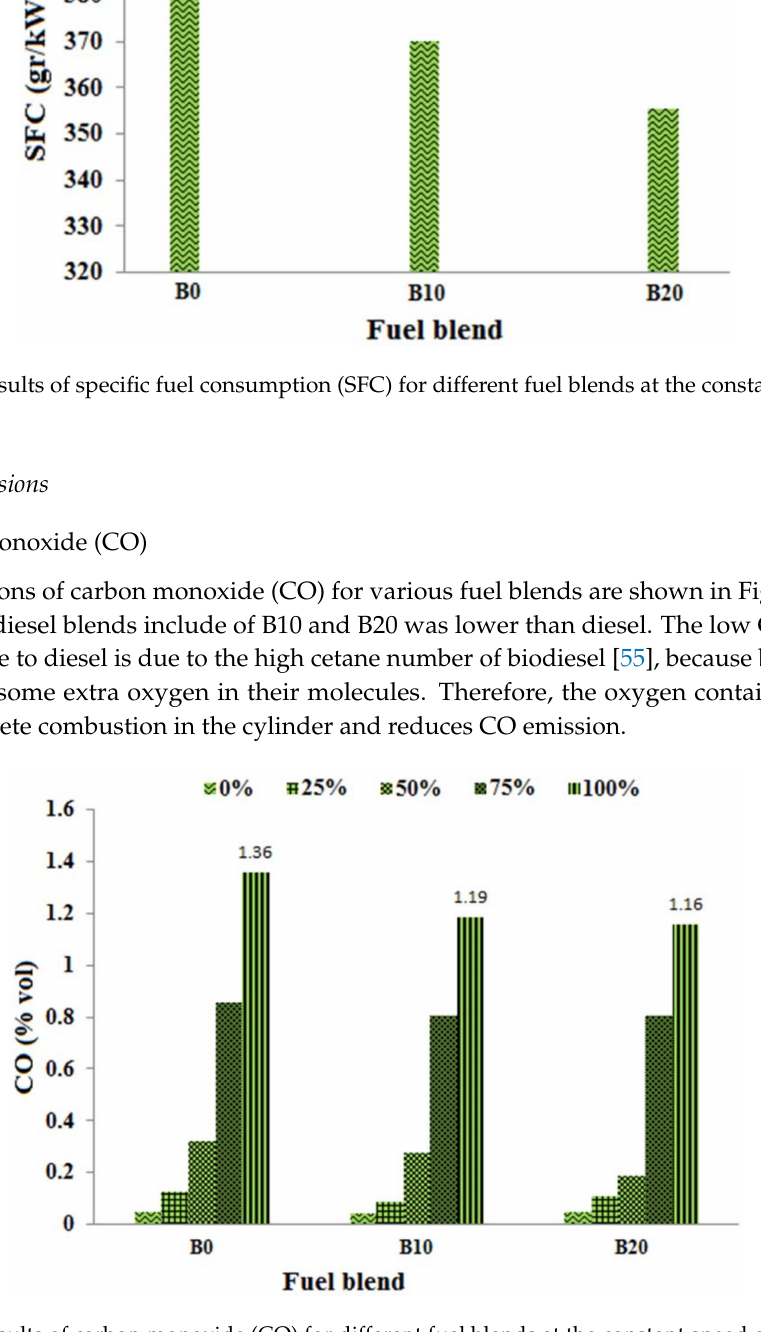
Figure 7. Results of carbon monoxide (CO) for different fuel blends at the constant speed of 2100